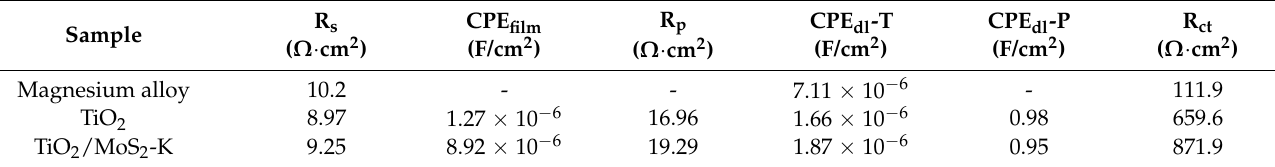
Figure 8. Equivalent circuits for EIS spectra: ( a ) magnesium alloy, ( b ) TiO 2 thin film and TiO 2 /MoS 2 -K thin film. Table 3. Electrochemical data extracted from ECs fitting of the EIS curves.